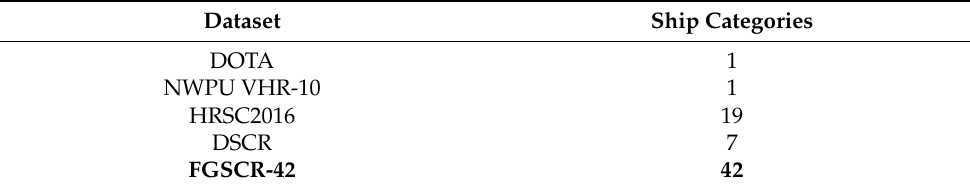
Table 3. Comparison among ship categories of FGSCR-42 and some other remote sensing